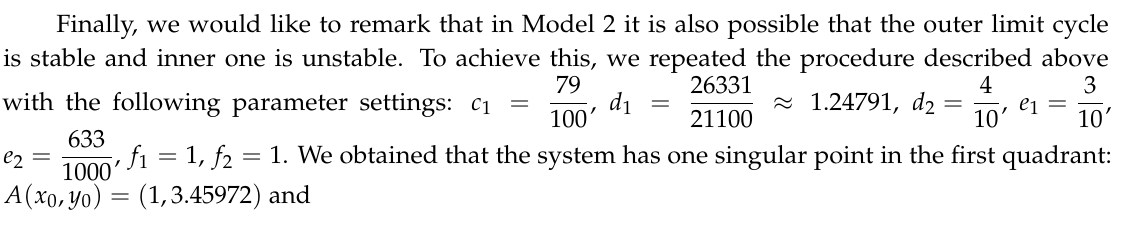
Figure 11. Model 2 with an unstable outer and a stable inner limit cycle. The trajectory is going outward, approaching the inner limit cycle as t → ∞ and the point A as t → − ∞ ( d = 0.05).